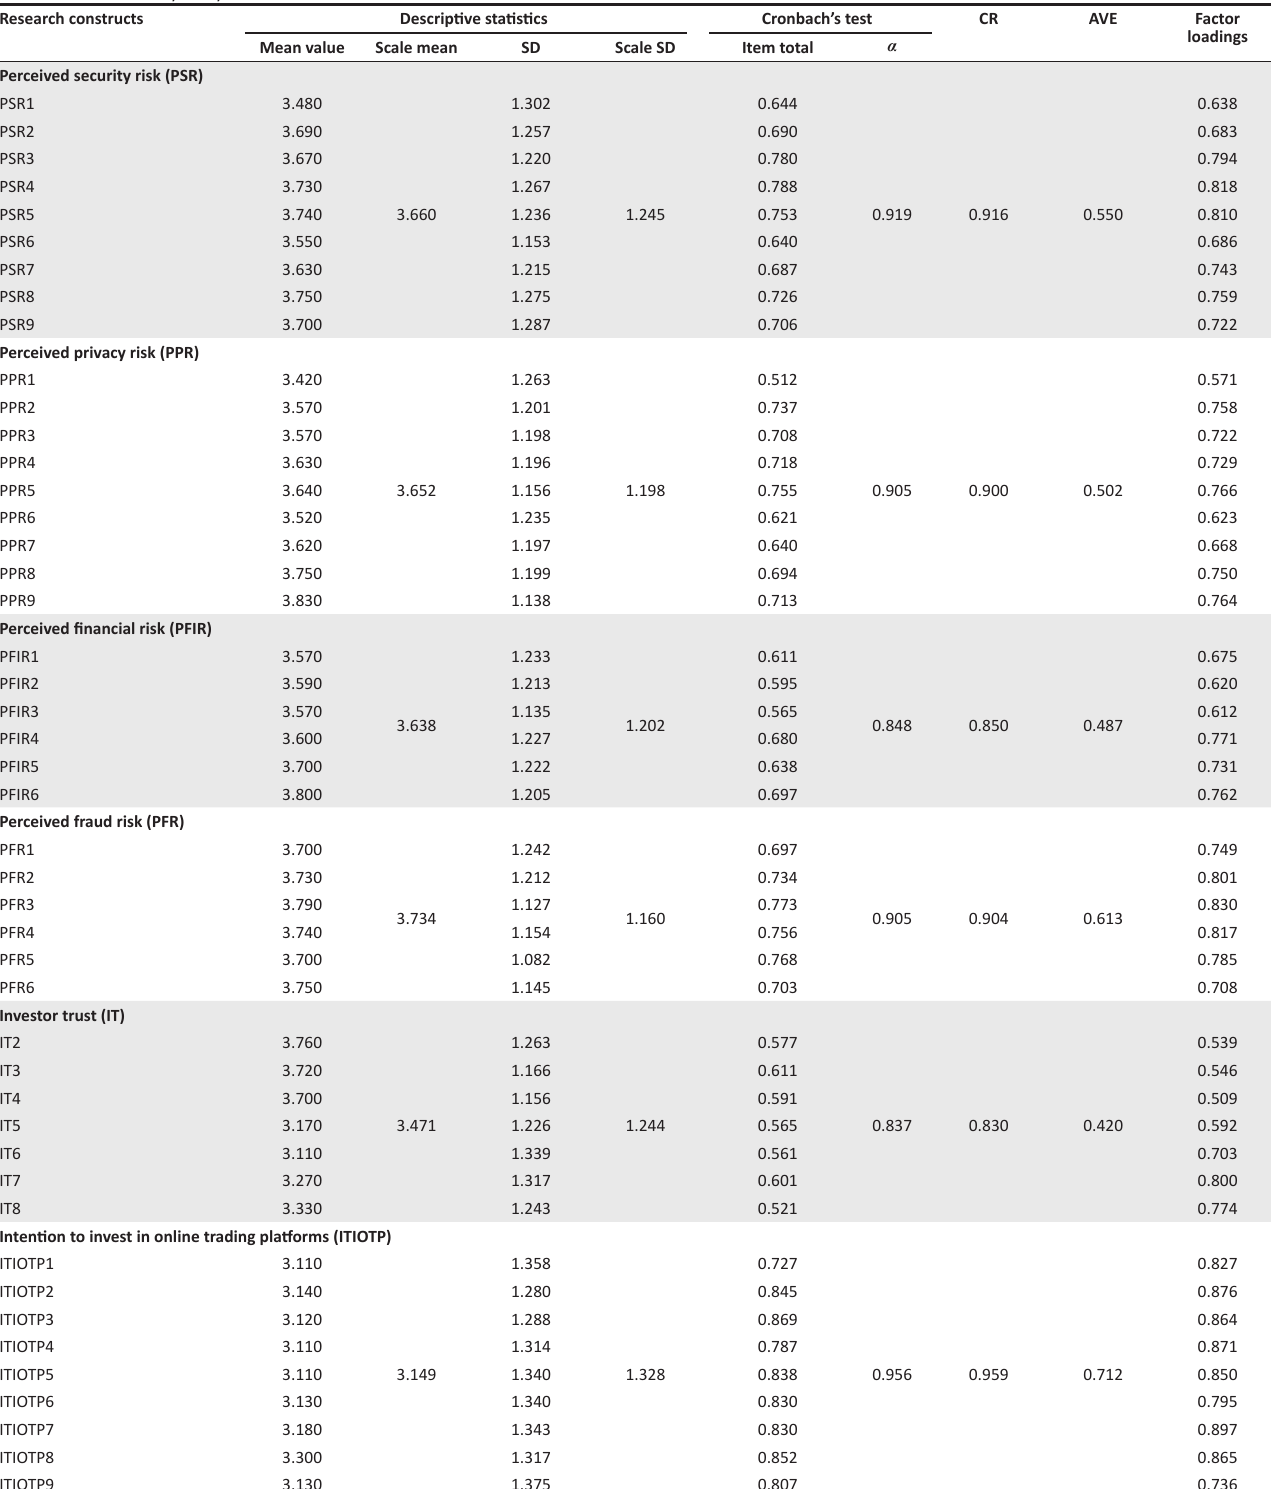
TABLE 2: Scale accuracy